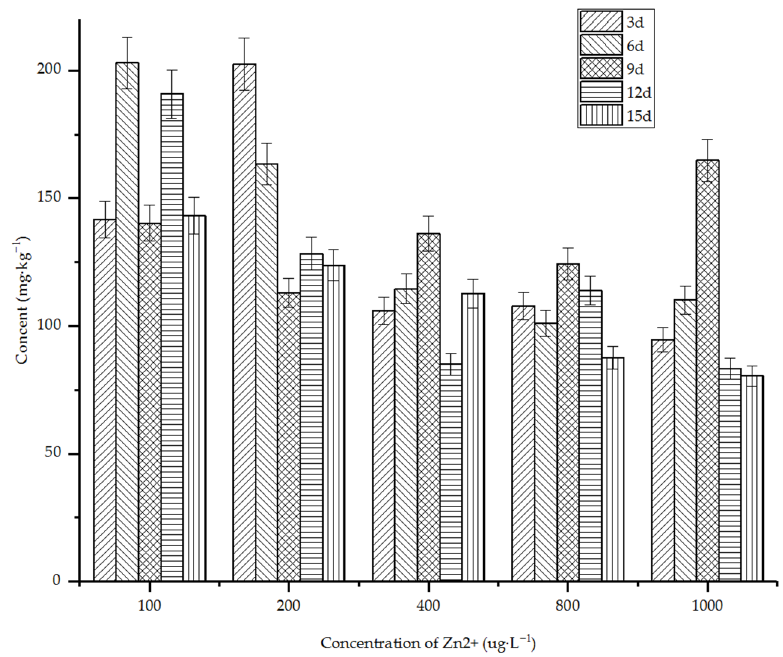
Figure 6. Absorption of heavy metal zinc ions by Suaeda salsa.